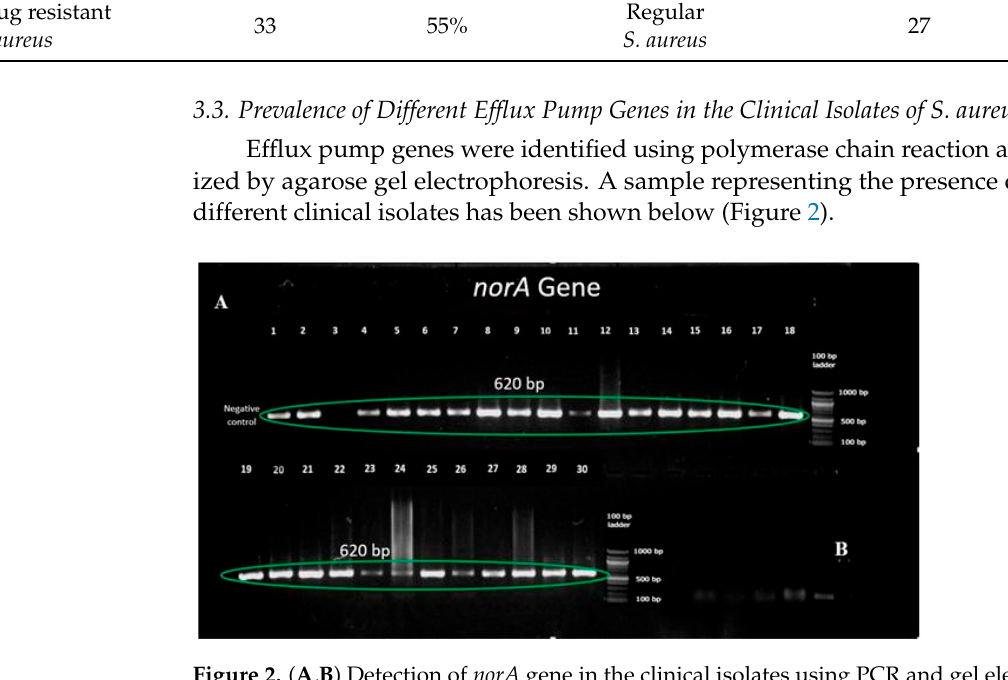
Figure 3. Prevalence of different efflux pump genes in the clinical isolates of S. aureus . Irrespective of their resistance status, the most effective combination of efflux pump genes was chromosomal encoded norA + norB + norC + mepA + sepA + mdeA among the clinical isolates including MRSA and MSSA, which provided a higher prevalence of resistance against the tested antibiotics (Figure 4). Six chromosomal genes were found to be 47.2% and 70.8% in methicillin-resistant S. aureus (MRSA) and methicillin-sensitive S. aureus (MSSA) clinical isolates, respectively. Two plasmid encoded genes such as qac A/B and smr along with chromosomal encoded genes were present in only MDR MRSA (11.1%). However, qacA/B along with six chromosomal encoded genes was found in both MDR MRSA (11.1%) and MDR MSSA (4.2%) isolates (Figure 4).